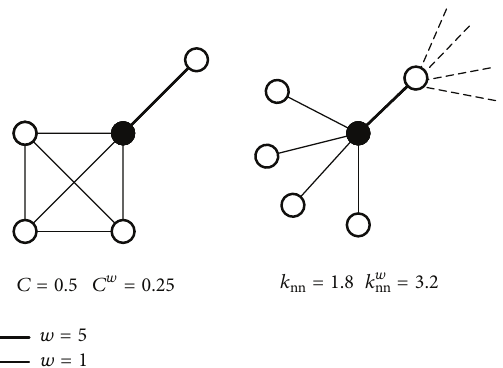
Figure 4: Examples of local configurations whose topological and weighted quantities are different [1].